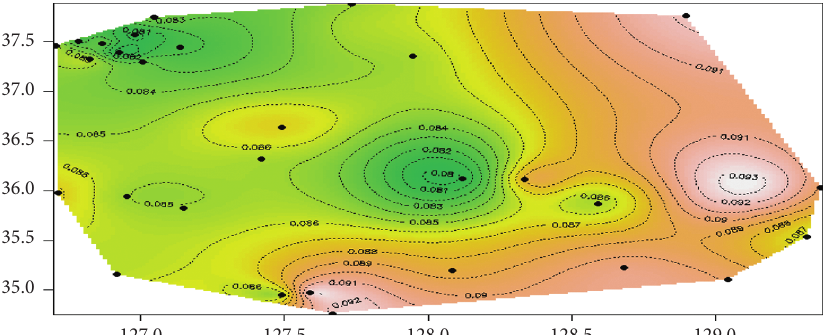
Figure 6: Interpolations of the 5 years’ return level for extreme ozone concentration in 29 air monitoring sites versus longitude ( x -axis) and latitude ( y -axis) in South Korea.